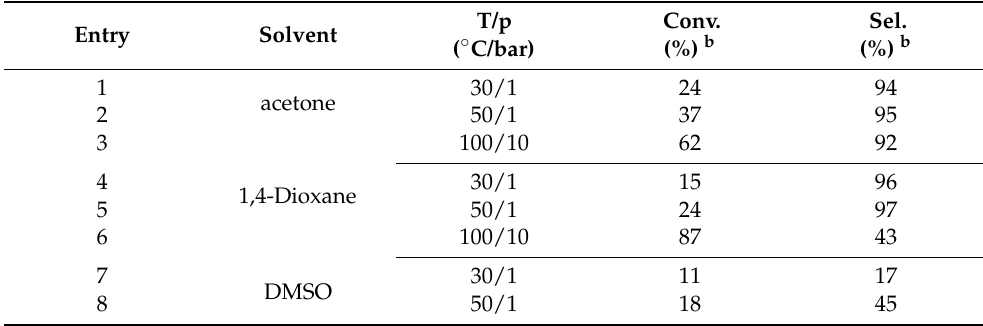
Table 4. The CF-acetalization of amide 2a a